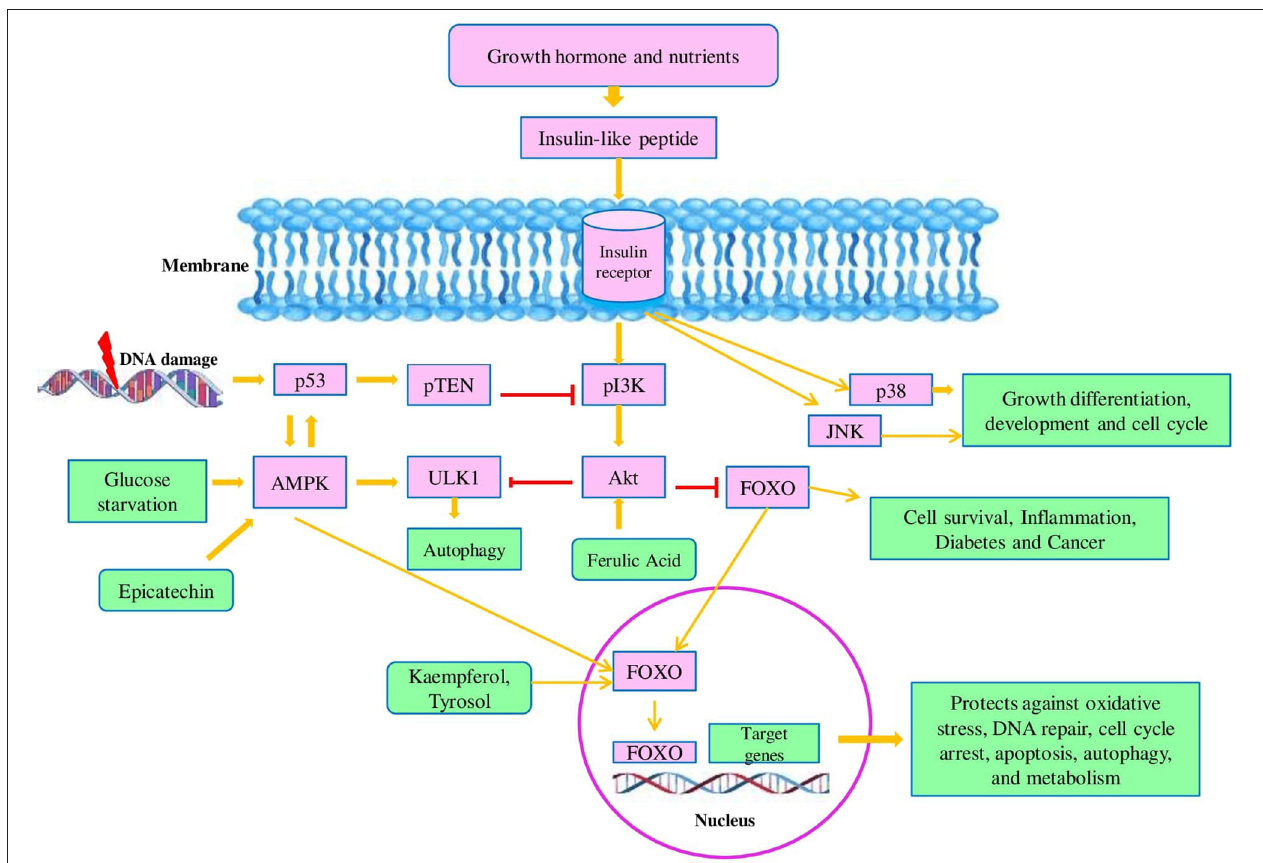
FIGURE 4 | Model of the insulin/insulin-like growth factor signaling (IIS) pathway: in response to growth hormones and nutrients, insulin as a ligand binds to membrane-bound glycoprotein receptors which results in a conformational change in membrane-embedded glycoprotein. This insulin ligand-receptor complex mediates the activation of tyrosine kinases by their phosphorylation. Tyrosine kinase (TK) is responsible for the phosphorylation of IRS family proteins and opens the binding sites for various signaling pathways. TK mediates activation of phosphatidylinositol kinase (PI3K). Moreover, PI3K activated the protein kinase B (Akt) which modulates cellular processes like cell survival and inflammation by phosphorylation and suppression of FOXOs. In response to DNA, damage p53 is activated and accelerates the activity of pTEN which in turn inhibited the PI3K and prevents the activation of Akt- mediated repression of FOXO. The insulin ligand-receptor complex also activates the MAPK family members like p38 and c-Jun-terminal kinase (JNK) which are the chief players of cell growth, development, apoptosis, and inflammation. Under glucose starvation conditions, adenosine 5 ′ -monophosphate-activated protein kinase (AMPK) is activated and induces autophagy by the acceleration of the ULK1 kinase whereas Akt diminished the activity of ULK1 kinase. AMPK also activates the FOXO and promoted the FOXO transcriptional activity. Additionally, p53 and AMPK activate each